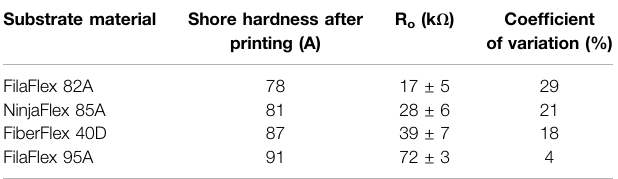
TABLE 6 | Values of the initial electrical resistance of the soft gripper with in situ printed sensing elements. Substrate material